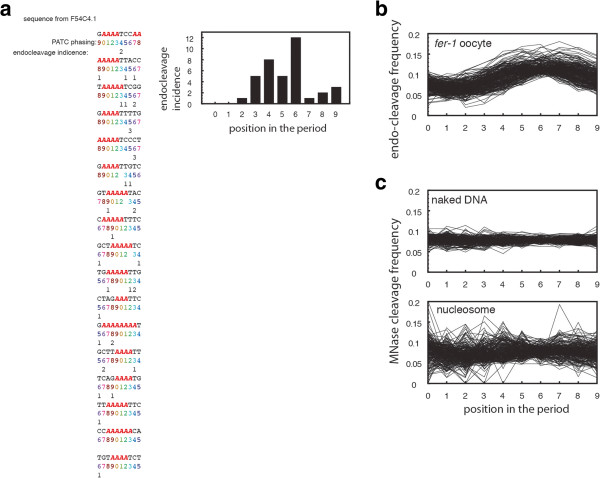
Rotational positioning of the activated oocyte chromatin in regions that are enriched for the periodic A(n)/T(n) clusters (PATC). (a) An example of examining the endo-cleavage events for different rotational phasing of the DNA double helix. A DNA segment of strong PATC character was selected from the intronic sequence of gene F54C4.1. Integer numbers from 0 to 9 below each line of sequences are used to indicate the PATC phasing number (that is, the positions relative to the A(n)/T(n) face, which is designated as 0). In a second line, the numbers of endo-cleavage events are indicated. The accessibility for each of the ten phase bins is measured by summing the endo-cleavage events occurring at the same face. The bar graph plots the endo-cleavage frequency as a function of the PATC phasing number. (b) For genome-wide analyses, the total endo-cleavage sites for each of the ten phase bins were separated into 256 classes according to the cleavage site sequence (NN|NN). The comparison of DNA accessibility among the ten phase bins was then performed by using cleavage sites of the same sequence, generating a total of 256 comparisons. For each of the 256 tetramer sequences, cleavage frequency (normalized by the frequency of the corresponding tetramer at the cleavage sites) is plotted as a function of the PATC phasing number for activated fer-1(b232) oocytes. (c) Same analysis performed on MNase-digested naked DNA and nucleosome cores.